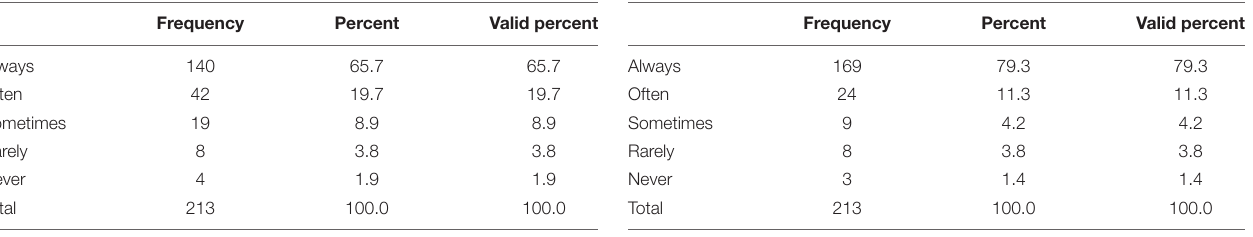
TABLE 4 | I use English for email correspondence with other members.